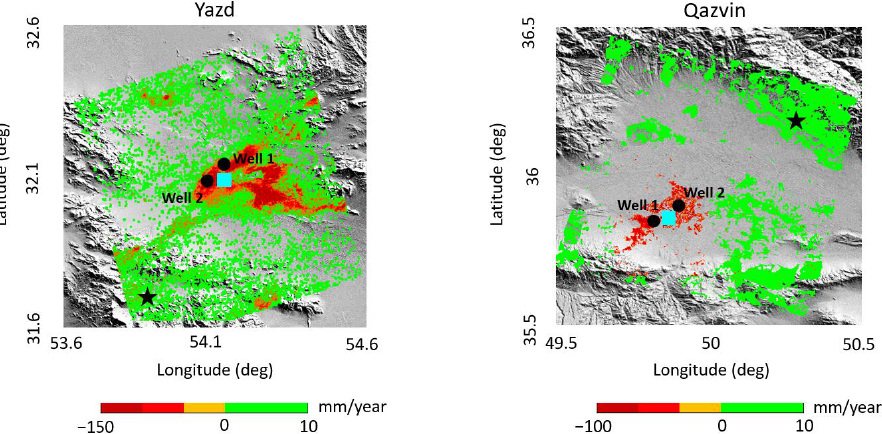
Figure 9. Line-of-sight direction displacement velocity maps of two areas. The black star and circles